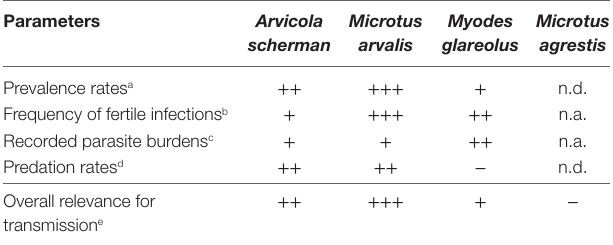
Table 2 | Qualitative assessment on the relative importance of the investigated vole species for the transmission of Echinococcus multilocularis based on the results of this